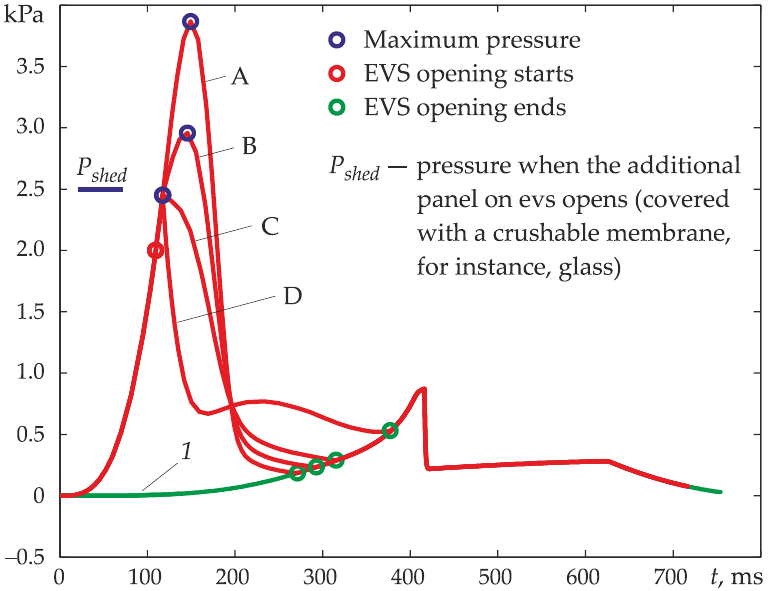
Figure 9. Excessive pressure of an explosion inside a kitchen: ( А ) non-upgraded EVS; ( B ) EVS with an additional 0.1 m 2 opening; ( C ) EVS with a 0.25 m 2 opening; ( D ) EVS with a 0.5 m 2 opening; 1 — explosive pressure inside the kitchen with a fully open window area.